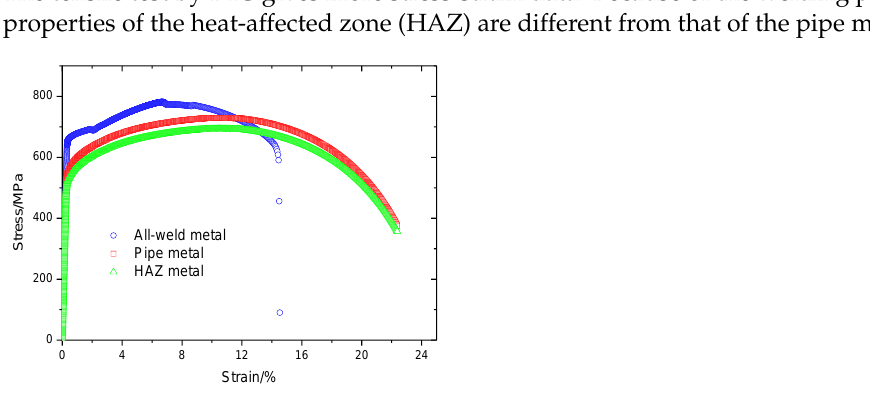
Figure 4. True stress-strain curve for pipe metal by DIC, HAZ metal and all-weld-metal.